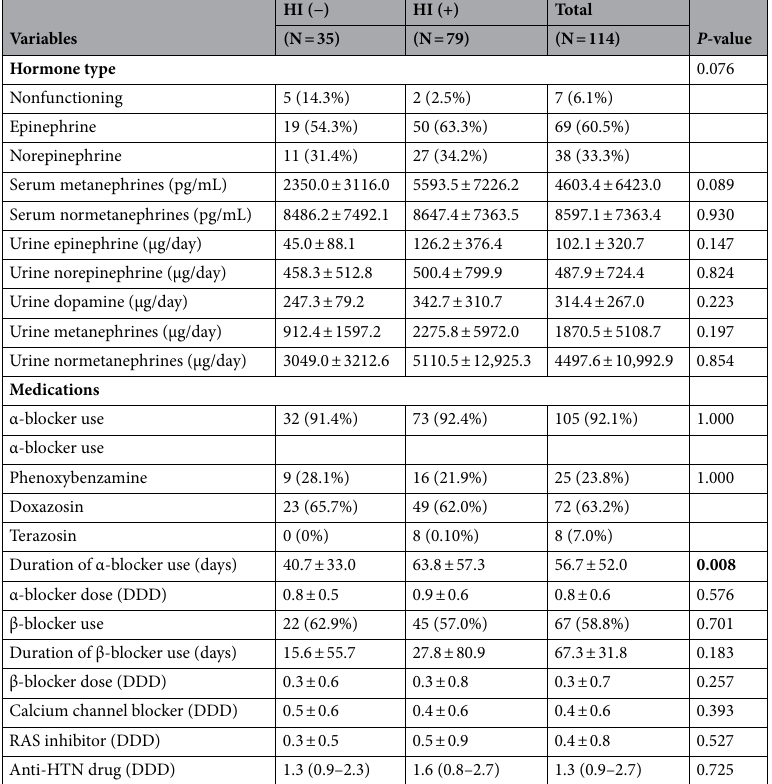
Table 2. Biochemical characteristics, and medications of study subjects according to hemodynamic instability (HI). Data are presented as the mean ± standard deviation, median (interquartile range) or n (%). HI, hemodynamic instability; SBP, systolic blood pressure; DDD, daily defined dose; HTN, hypertension.